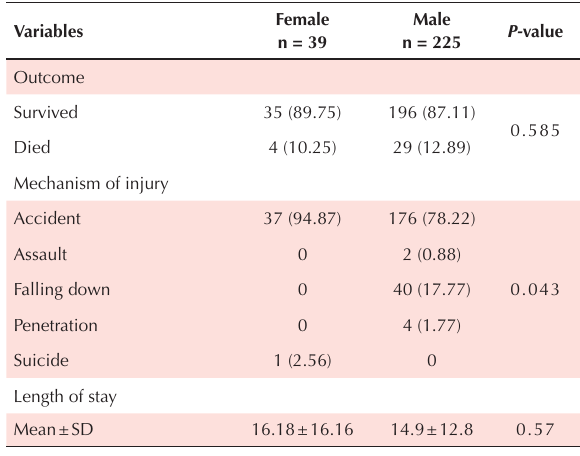
Table 1. Descriptive statistics of the patients by gender